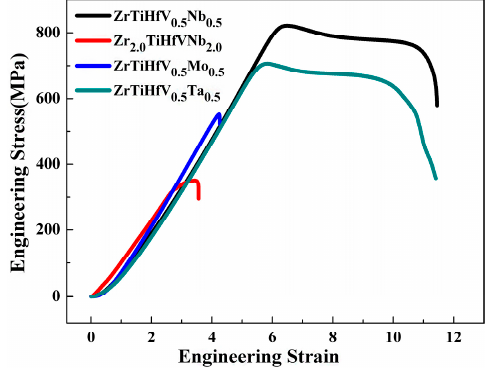
Figure 7. The tension stress–strain curves of the RHEAs.